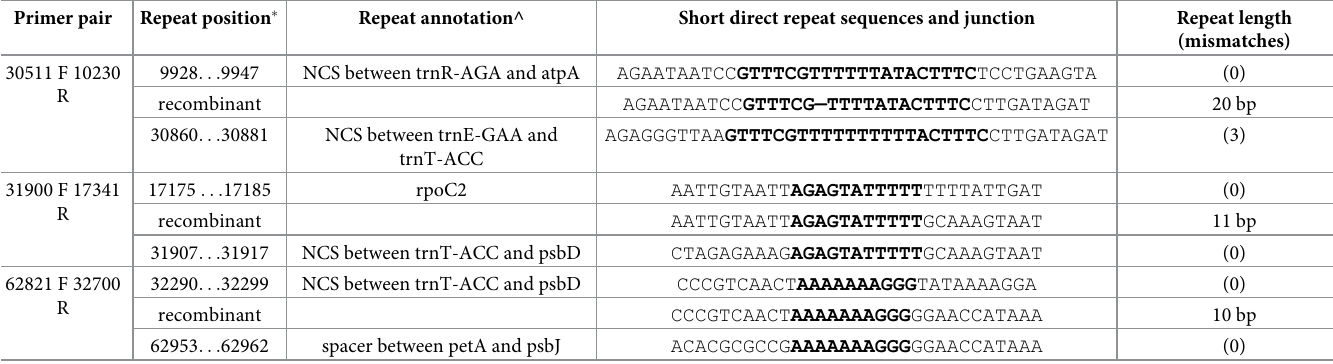
� Indicates the positions of the short direct repeats (shown in bold) referred to the number of the nucleotides in the A . thaliana chloroplast genome sequence. ^ Indicates the annotation of the direct repeat within the coding or non-coding sequence (NCS) of the chloroplast